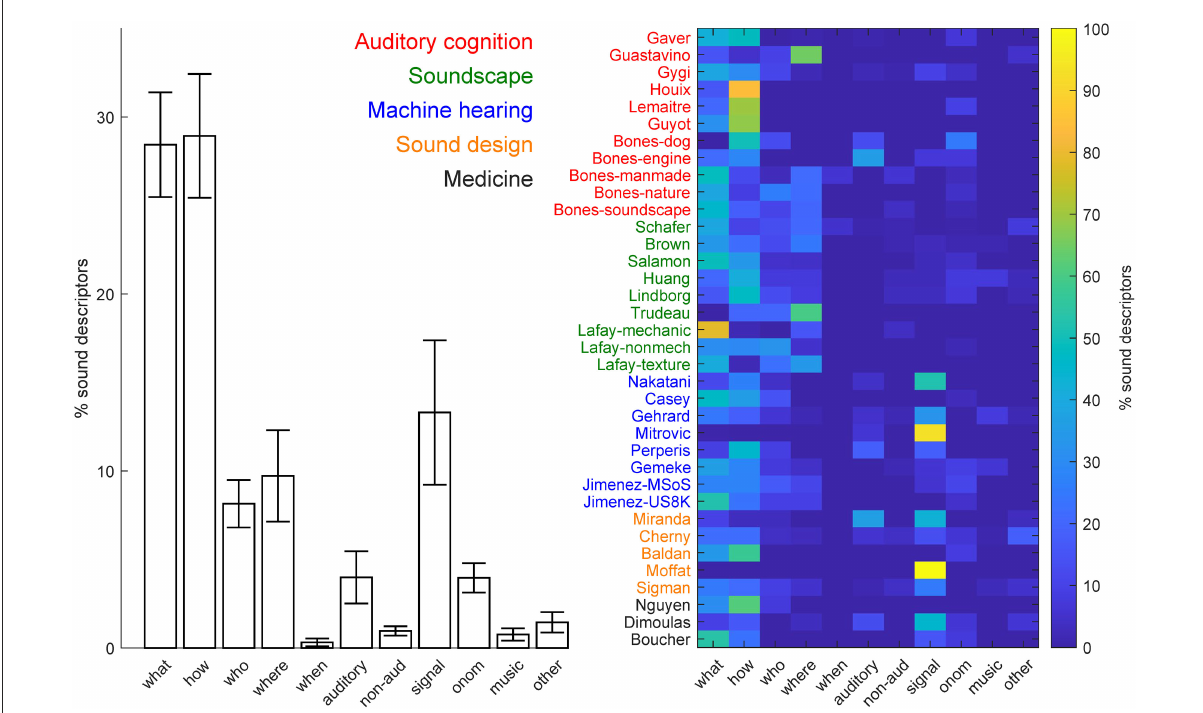
FIGURE5 Percentage of sound descriptors in the different categories and subcategories after exclusion of the generic descriptors. Left = average % across knowledge organization systems (error-bar = ± 1